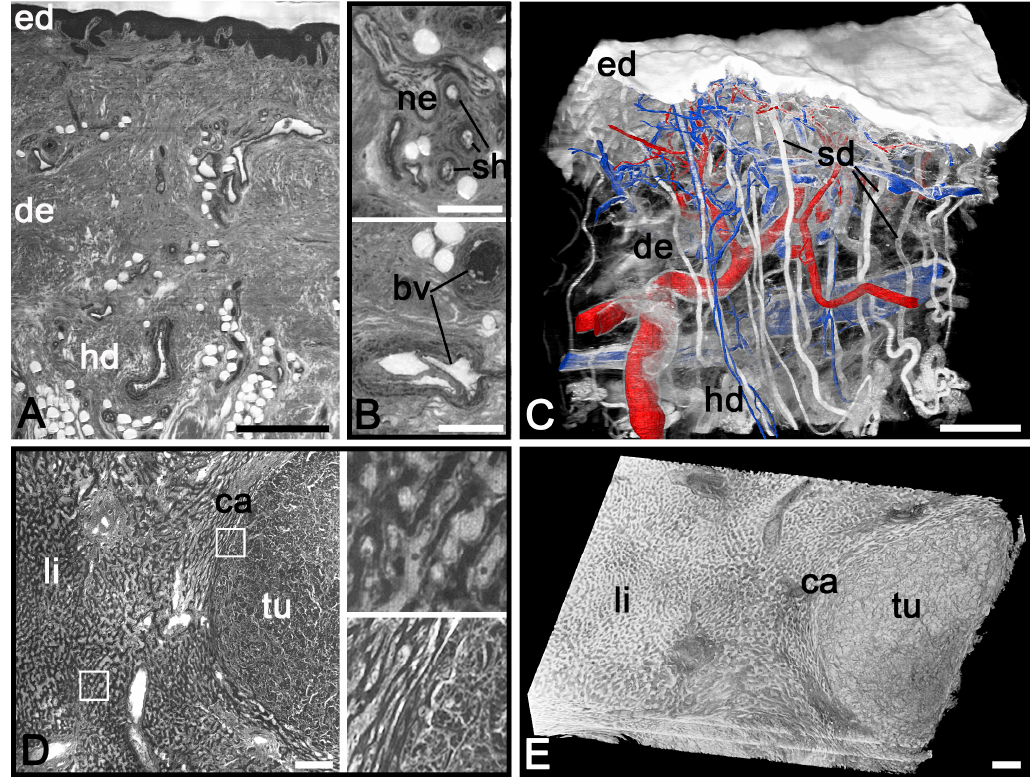
Figure 3. HREM data created from material harvested from adult human ( A – C ) skin biopsies. Virtual resection perpendicular to the original HREM section plane ( A ). ( B ) shows details from the original HREM sections to demonstrate HREM’s ability to visualize small dermal nerves (ne) and a Suquet-Hoyer canal (sh) in the top image and small dermal blood vessels (bv) in the bottom image. ( C ) shows a semitransparent 3D volume model of the sample combined with surface models of the lumina of the dermal arteries (red) and veins (blue). ( D , E ) show metastatic material (tu) in a liver (li) biopsy. Original 2D HREM section in ( D ). Boxed areas are zoomed-in views provided as inlays to the right. ( E ) shows a 3D volume model. ed, epidermis; de, dermis; hd, hypodermis; ca, fibrous tumour capsule; sd, sweat duct. Scale bars 500 µm in ( A ), ( C ), ( D ), ( E ); 150 µm in ( B ).